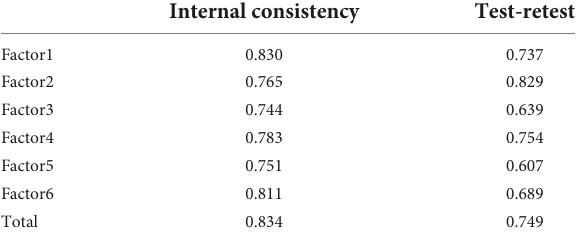
TABLE 5 The internal consistency and test-retest reliability of the